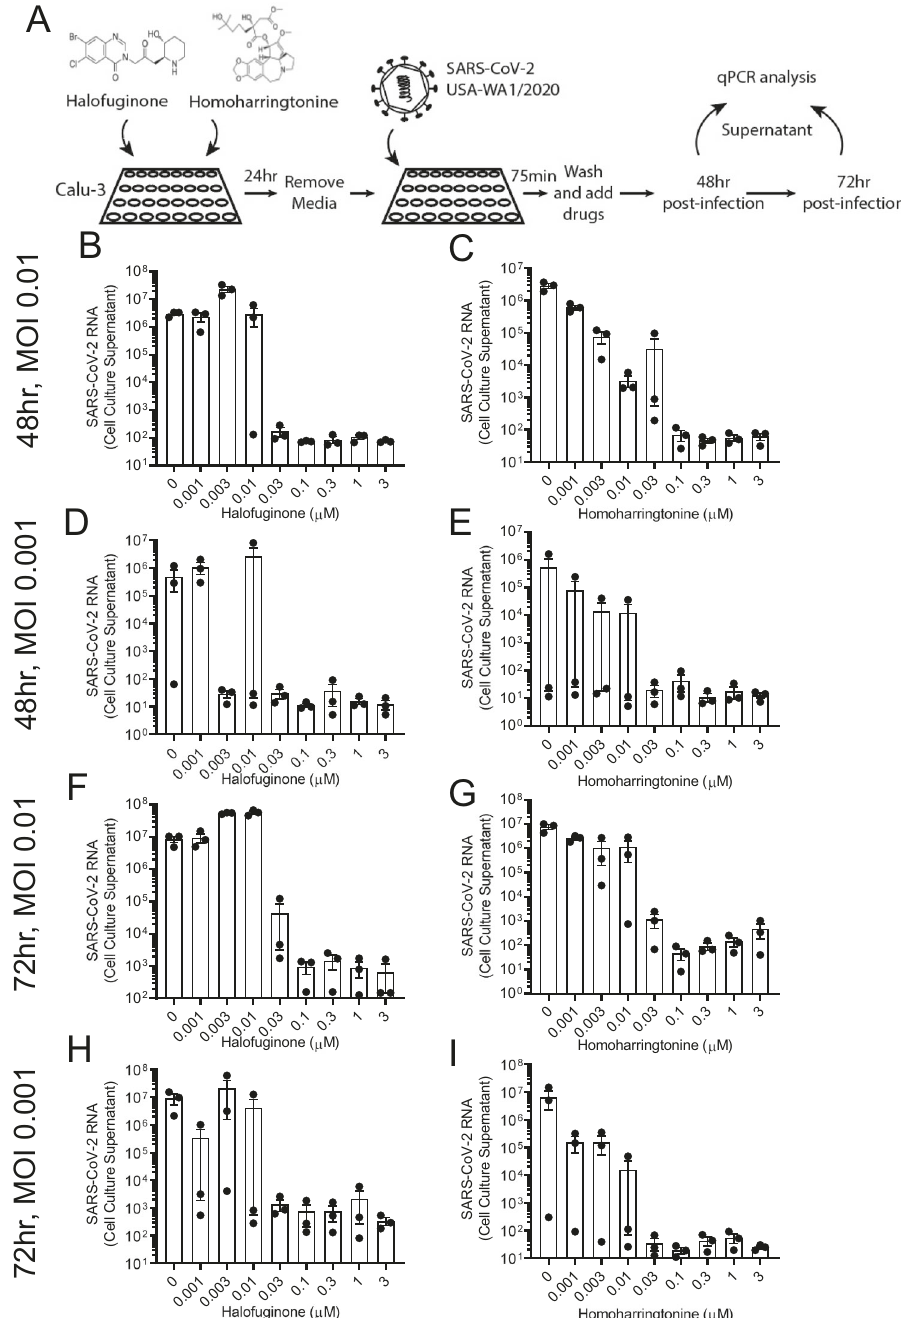
Fig. 8 Homoharringtonine and Halofuginone show ef fi cacy in blunting SARS CoV-2 infection. A Schematic of SARS-CoV-2 treatment strategy. Calu-3 cells were pretreated with Halofuginone (HFG) or Homoharringtonine (HHT) for 24h. Media was exchanged, and cells were exposed to SARS-CoV-2 virus for 75min, then exchanged for fresh media replenished with HFG or HHT. Supernatant samples were taken at 48 and 72h for qPCR analysis of viral RNA ( B – I ). B – I qPCR analysis of viral RNA in culture supernatant of Calu-3 cells under titration of HFG or HHT at 48h following an initial infection of SARS-CoV-2 using an MOI of 0.01 ( B – C ), or 0.001 ( D – E ), or at 72h after infection with an initial MOI of 0.01 ( F – G ) or 0.001 ( H – I ). Data represent mean ±SEM ( n = 3 biologically independent